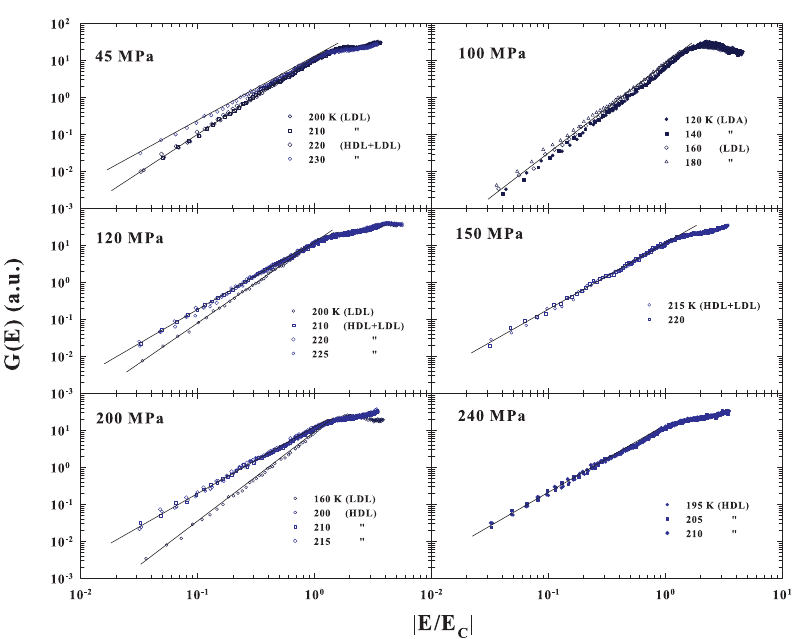
Figure 6. The DOS measured at the different P and T are reported in a log-log scale as a function of the reduced energy | E / E C | . The plot fully confirms the observations of a MCT scaling evolution only when the system is in the fragile, super-Arrhenius, status dominated by the energetic